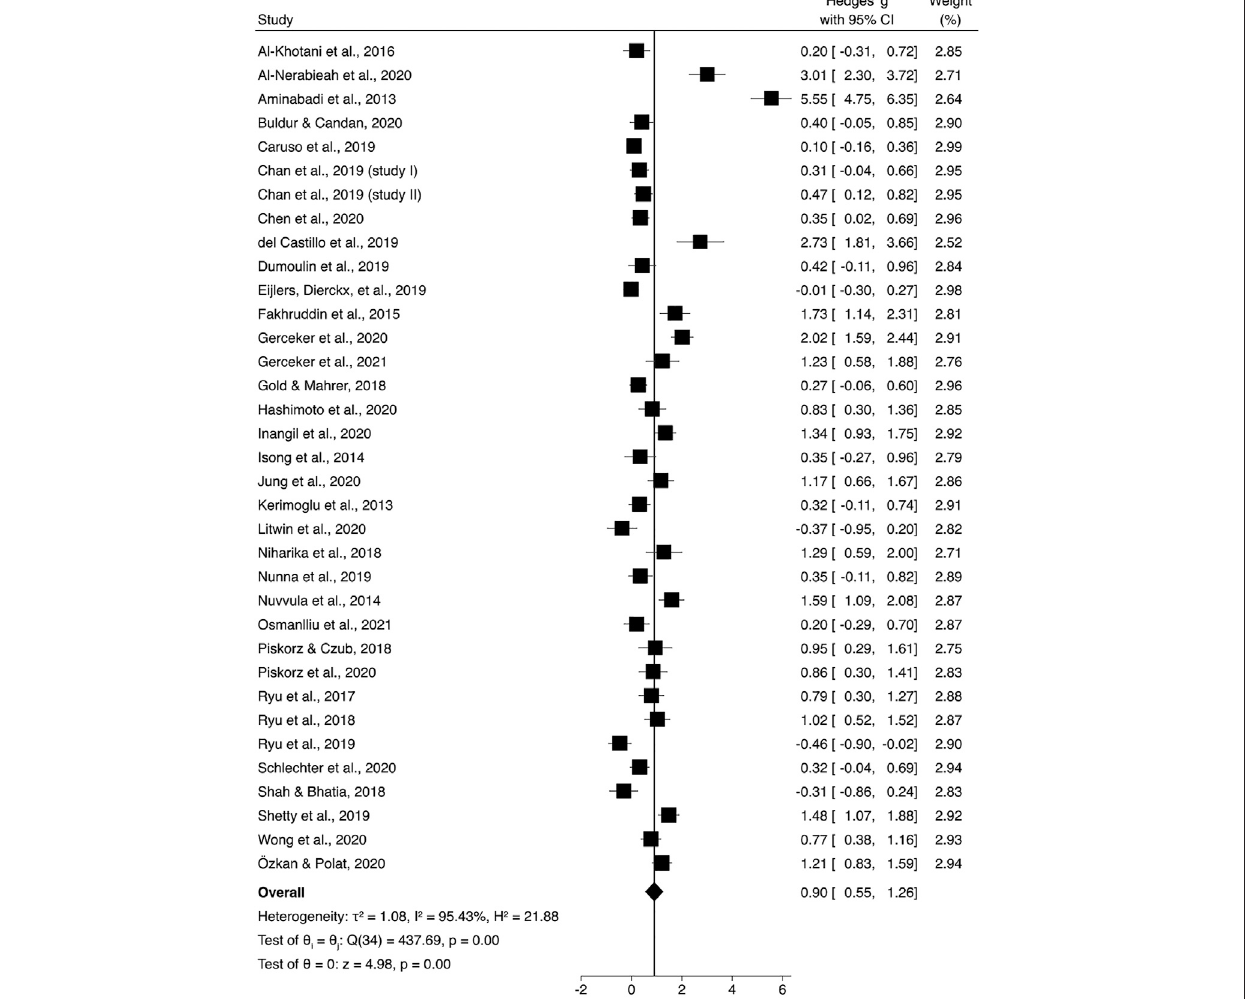
Frontiers in Virtual Reality |